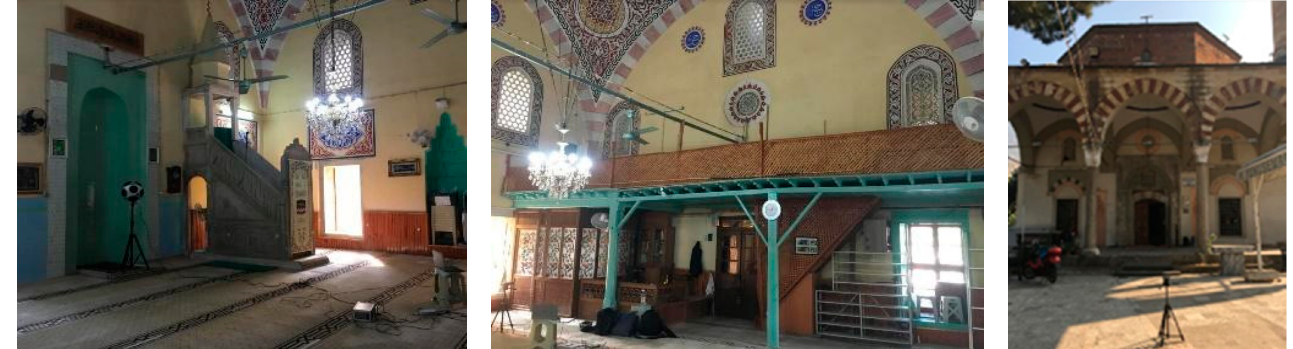
Figure 2. Interior views of main prayer hall and exterior view of Lalapa¸sa Mosque (photos by the authors).